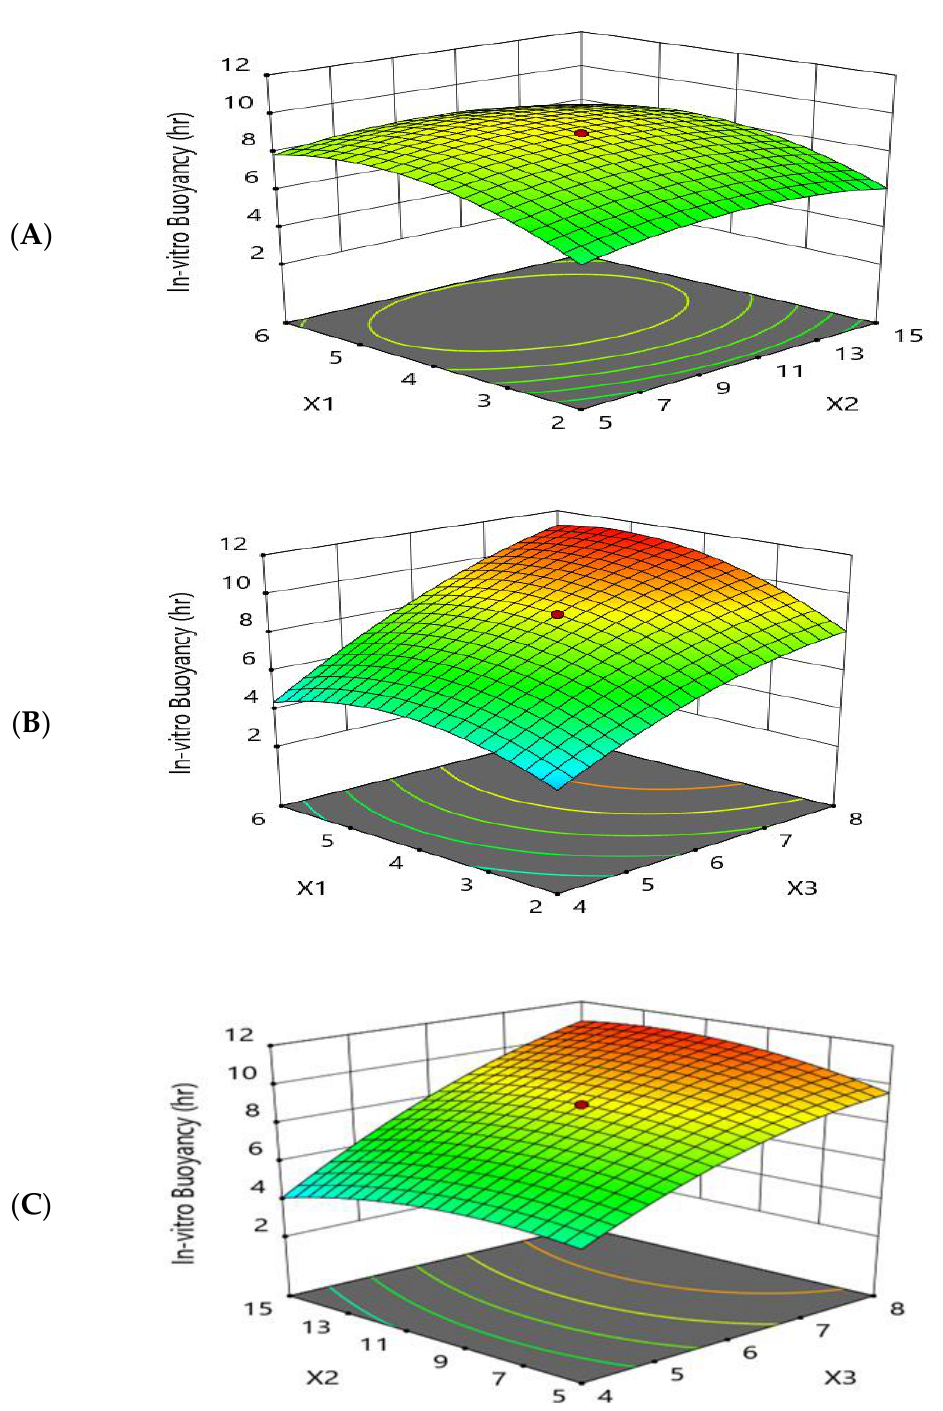
Figure 4. Response-surface-methodology plot for the effect of formulation factors (X1, X2, and X3) on the in vitro buoyancy (Y2). ( A ) Effect of sodium alginate concentration and cross-linker concentration on the in vitro buoyancy (Y2); ( B ) effect of sodium alginate concentration and sesame oil concentration on the in vitro buoyancy (Y2); and ( C ) effect of cross-linker concentration and sesame oil concentration on the in vitro buoyancy